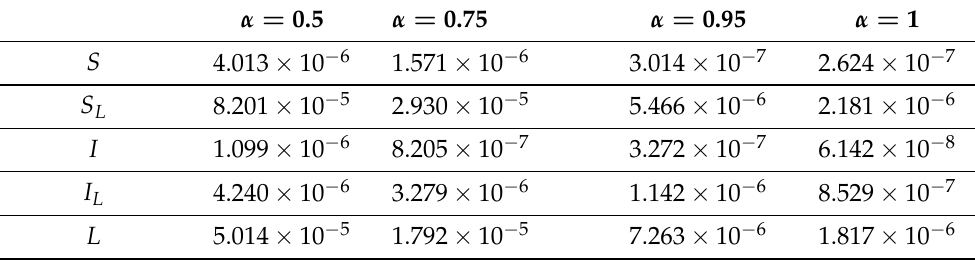
Table 4. Relative error of the state variables for different values of α when R 0 >